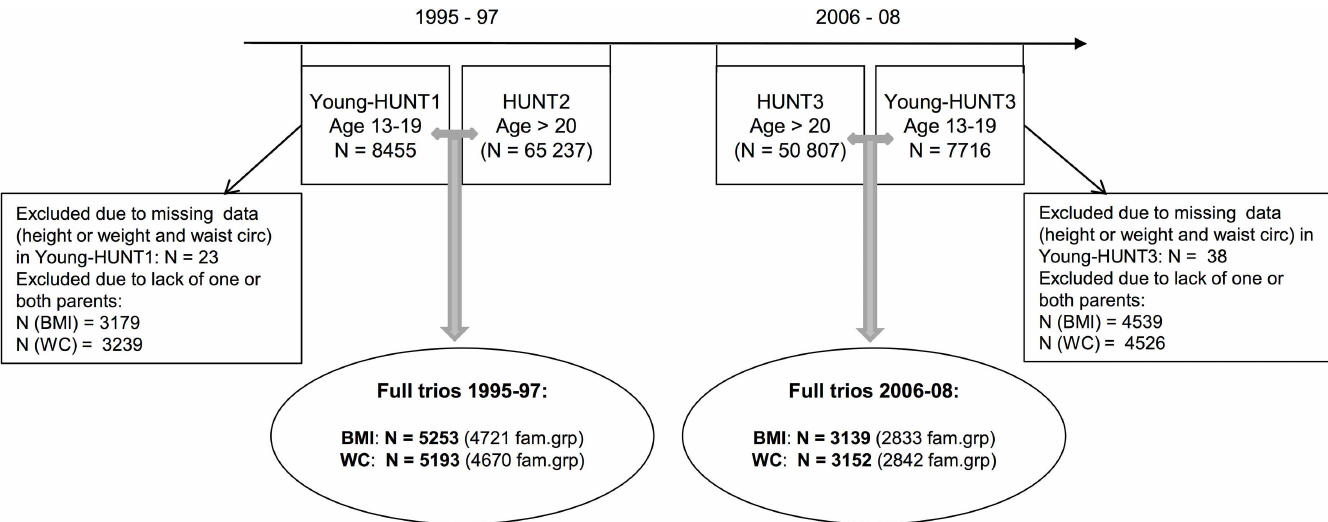
Fig 1. Study flowchart. Number of full parent-offspring trios organizedinto family groups(fam.grp) due to siblings.Abbreviations: BMI = Body mass index, WC = waist circumference